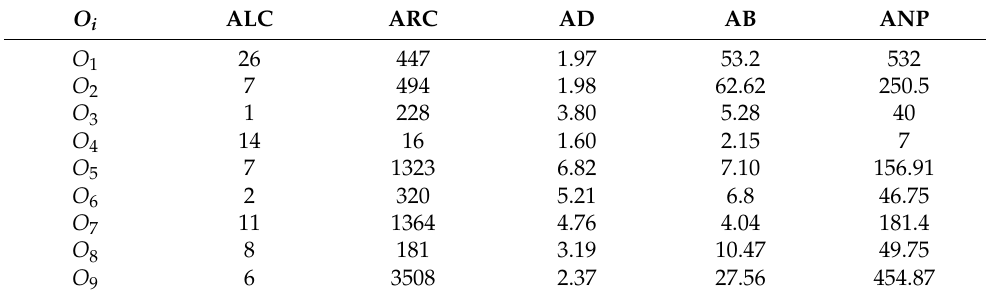
Table 2. Quantitative matrix Λ of the 5 complexity metrics for the ontologies in the dataset.